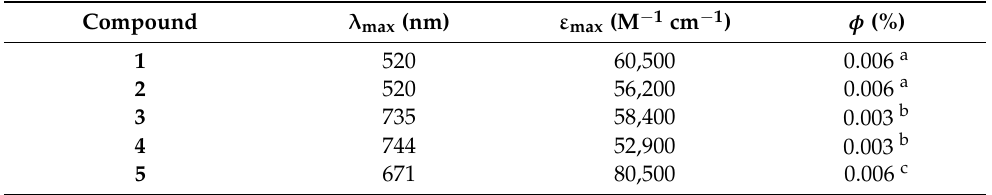
Table 1. Photochemical properties of protected